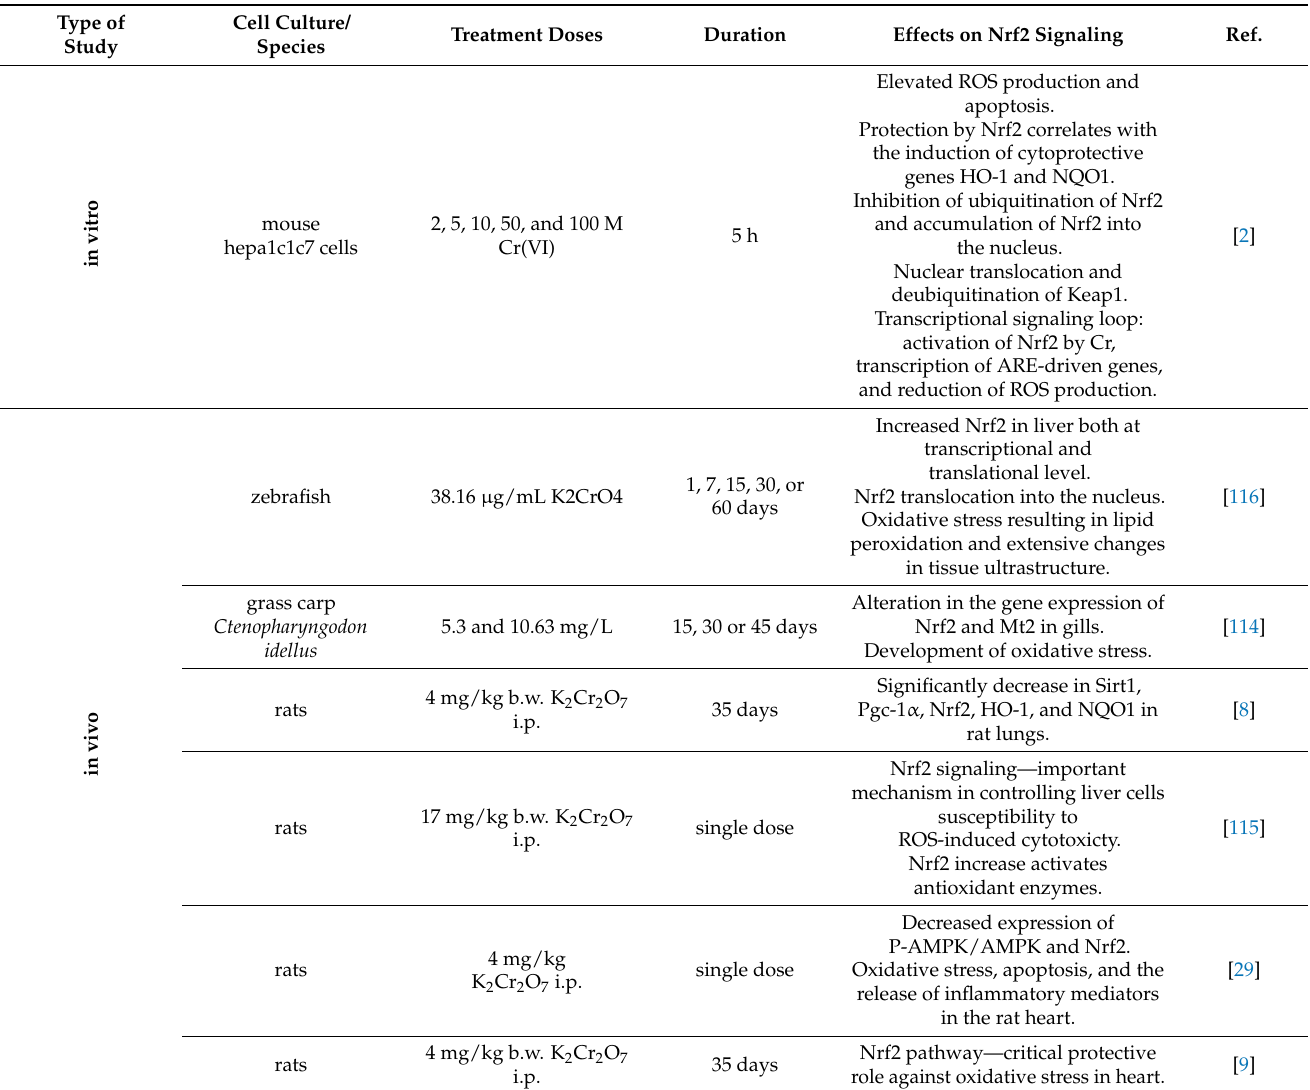
Table 6. Summary of studies analysing the effects of Cr on Nrf2